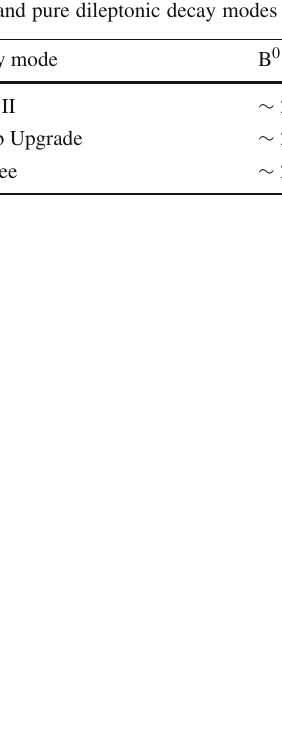
∗ 0 ( 892 ) τ − ν τ (pink) FCC-ee experiments. SM branching fractions are assumed. The yields